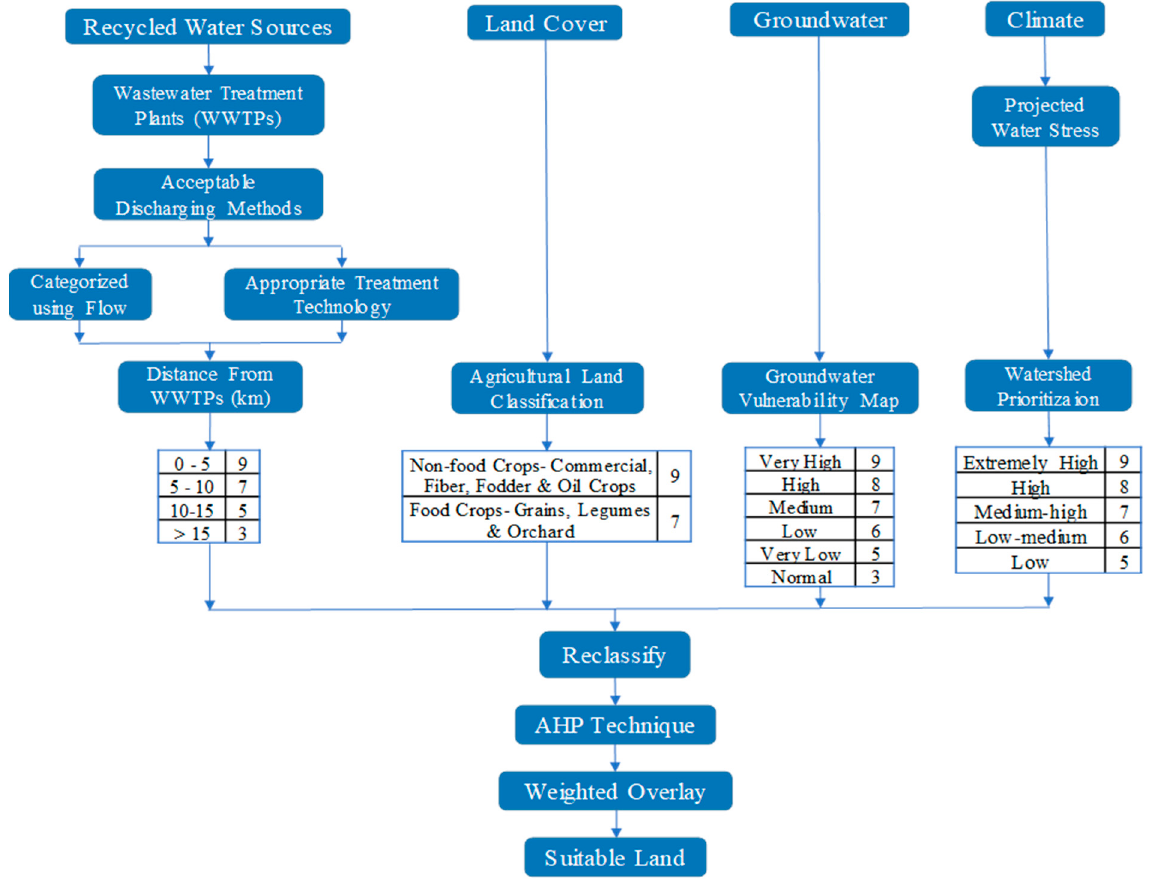
Figure 3. Developed decision hierarchy for the evaluation of suitable agricultural land for irrigation with recycled water. Table 2. Saaty’s [28] nine-point pairwise scale and definition to assign a weight to the criteria. Intensity of Importance